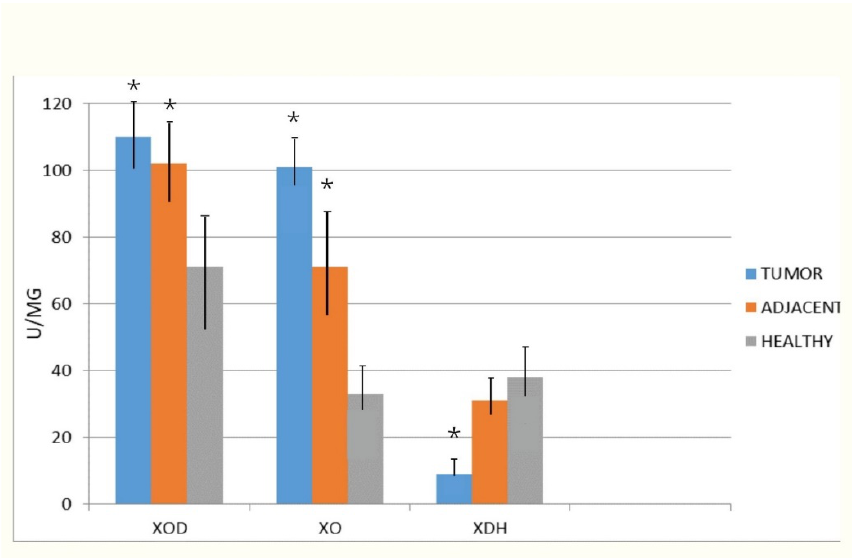
Figure 2. The activities of total Xanthine oxidoreductase (XOD), xanthine oxidase (XO), and xanthine dehydrogenase (XDH) in homogenates of investigated tissues. Xanthine oxidoreductase (XOD) and xanthine oxidase (XO) were measured in plasma according to the liberation of uric acid, in the presence of NADH (XOD) or absence of NADH (XO) when only molecular oxygen is an electron acceptor. The XDH activity was calculated by subtracting from XOD the XO activity * p < 0.001 compared with the healthy.